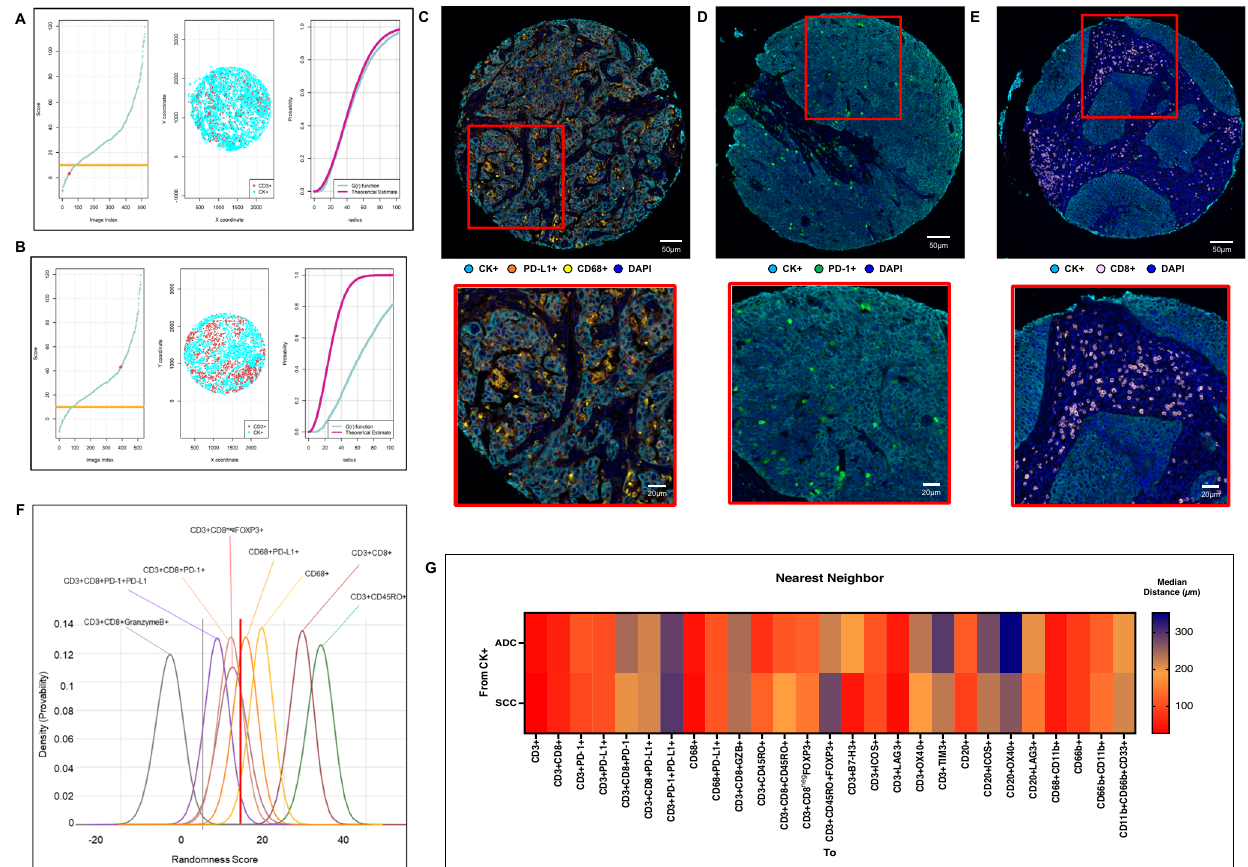
Fig. 3 | Nearest neighbor distance G function and theoretical Poisson curve score graphs showing different cellular patterns of distance from cytoker- atin+cells (malignant cells) to CD3+T-cells, and heat map representing dis- tance patterns by histologic type. A , B Representative example of the scoring system across tissue specimens and threshold to be considered part of the mixed ( A ) or unmixed ( B ) pattern. Graphs represent the scoring system (left), point pat- tern distributions related to the major T-cell population (middle), and G function and theoreticalPoissoncurve area(right).Composite spectralmixing images from multiplex immuno fl uorescence (mIF; 20× magni fi cation, scale bars represent 50 µ m on each image) showing a representative image of mixed pattern of mac- rophages PD-L1 expression ( C ) and PD-1+ antigen experience T-cells ( D ), in the bottom inside detail of the pattern (mIF; 40× magni fi cation, scale bars represent 20 µ m on each image). Unmixed pattern of CD8+cytotoxic T-cells ( E ) and in their bottom inside detail of the pattern (mIF; 40× magni fi cation, scale bars represent 20 µ moneachimage). F ModelinteractionbasedontheGfunctionandtheoretical